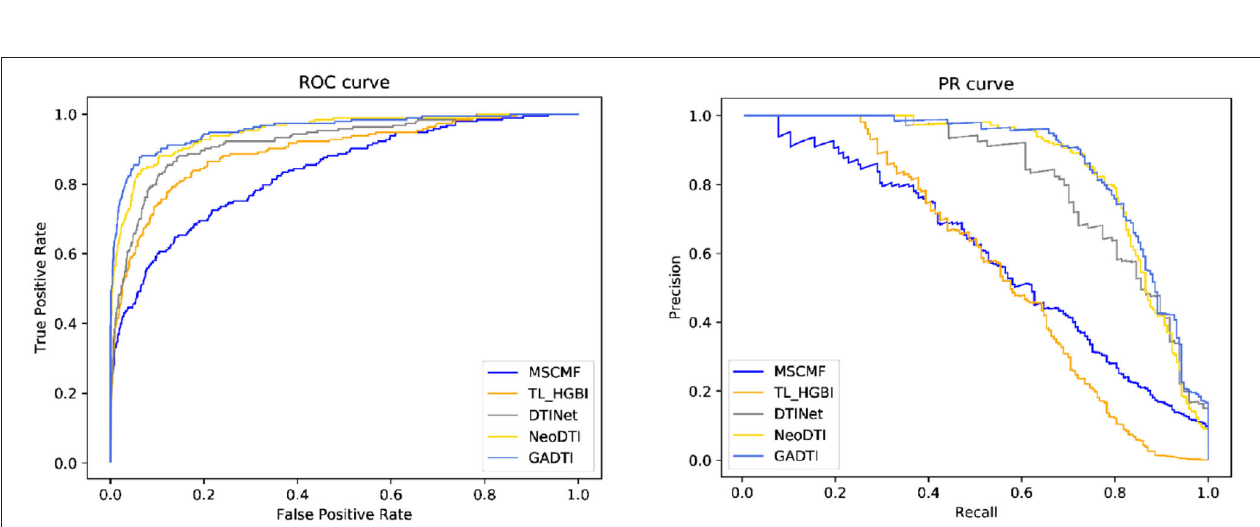
FIGURE 5 | The ROC curves and PR curves of different methods (#positive: #negative = 1:10).